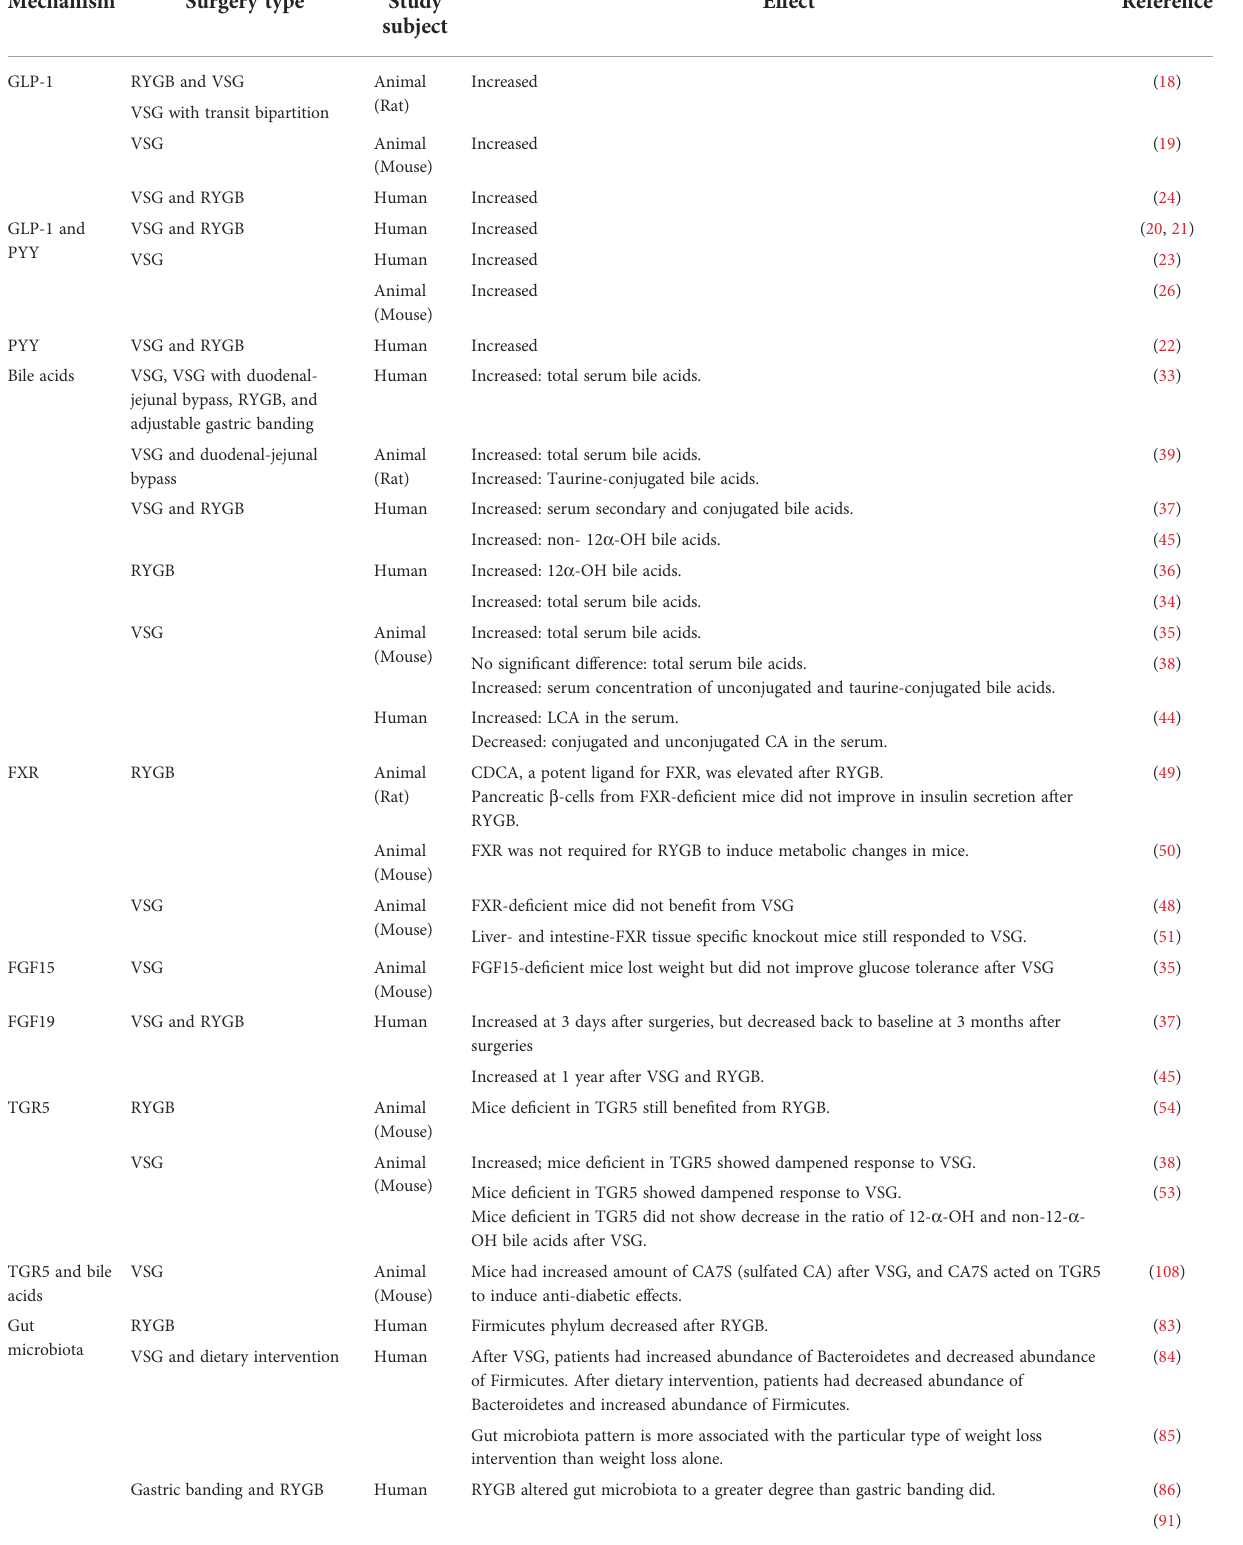
TABLE 1 List of potential mechanisms underlying metabolic surgery, and how they are affected by the surgery.